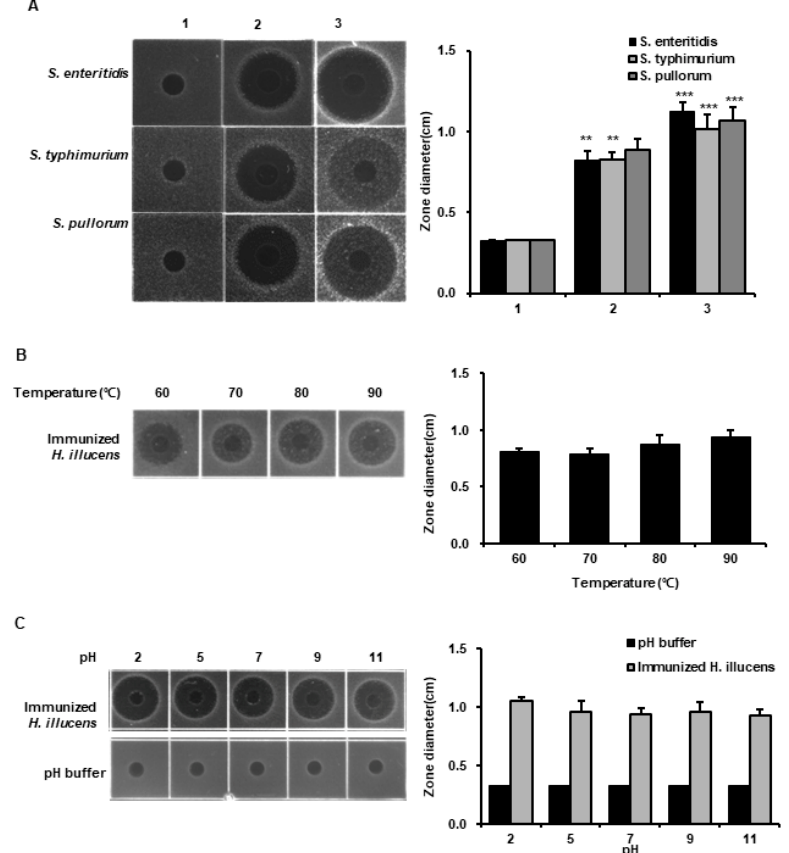
Figure 3. Evaluations of antimicrobial activities to S. enteritidis , S. typhimurium and S. pullorum and of the heat and pH stabilities of L. casei -immunized HIL hemolymph as determined by RDA. ( A ) Antimicrobial activities of L. casei -immunized HIL hemolymph against S. enteritidis , S. typhimurium , and S. pullorum . Lane 1, non-immunized HIL hemolymph; lane 2, melittin (1 µ g); lane 3, L. casei -immunized HIL hemolymph. The values of column graphs are presented as the mean ± S.D. ** and *** indicate p < 0.01 and p < 0.005 vs. lane 1, respectively. ( B ) Thermal stabilities of the antimicrobial activities of hemolymphs. Hemolymphs were incubated at 60, 70, 80, or 90 ◦ C for 24 h. ( C ) pH stabilities of antimicrobial activity of L. casei -immunized HIL hemolymph. A total of 2 µ L of Hemolymphs was mixed in 8 µ L of pH 2, 5, 7, 9, or 11 bu ff er for these evaluations. ( B , C ) E.coli was used as a target bacterium to confirm antimicrobial activity of L. casei -immunized HIL